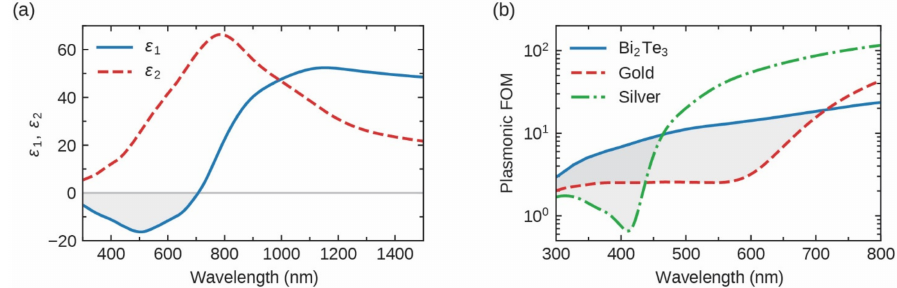
Figure 1. ( a ) Dielectric function of Bi 2 Te 3 adapted from [23] with a large absorption peak for ε 2 around 770 nm. Following the Kramers–Kronig relation, ε 1 had an anomalous jump to negative values for wavelengths smaller than 700 nm, allowing plasmonic resonances. ( b ) Comparison of the plasmonic figure of merit (FOM) of Bi 2 Te 3 , gold, and silver [34], revealing superior plasmonic performance of Bi 2 Te 3 for wavelengths below roughly 710 and 440 nm compared to gold and silver,